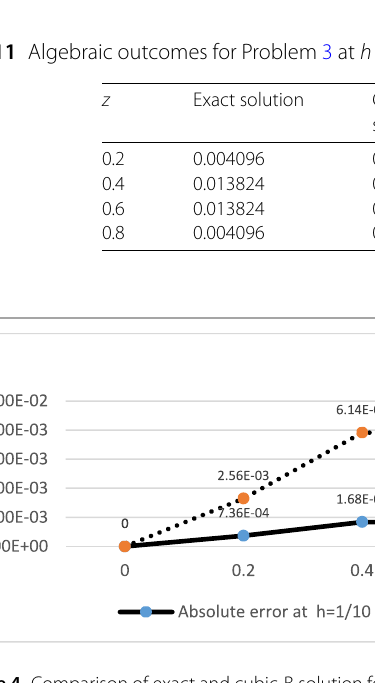
Figure 4 Comparison of exact and cubic-B solution for Problem